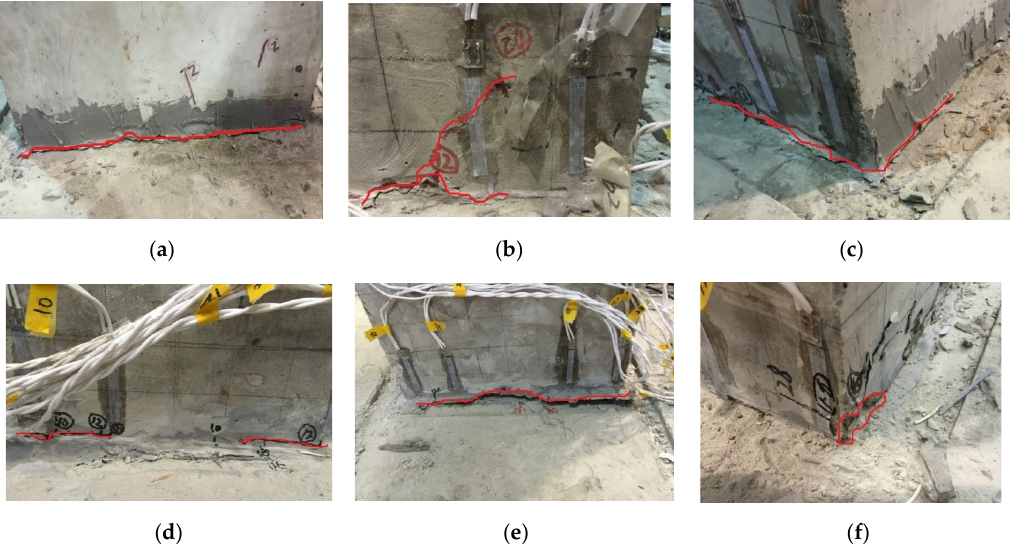
Figure 6. Failure mode of S1 and S2. ( a ) Pier bottom cracks of S1. ( b ) Oblique cracks of S1. ( c ) Pier bottom buckling of S1. ( d ) Pier bottom cracks of S2. ( e ) Penetration cracks of S2. ( f ) Pier bottom crushed of S2.